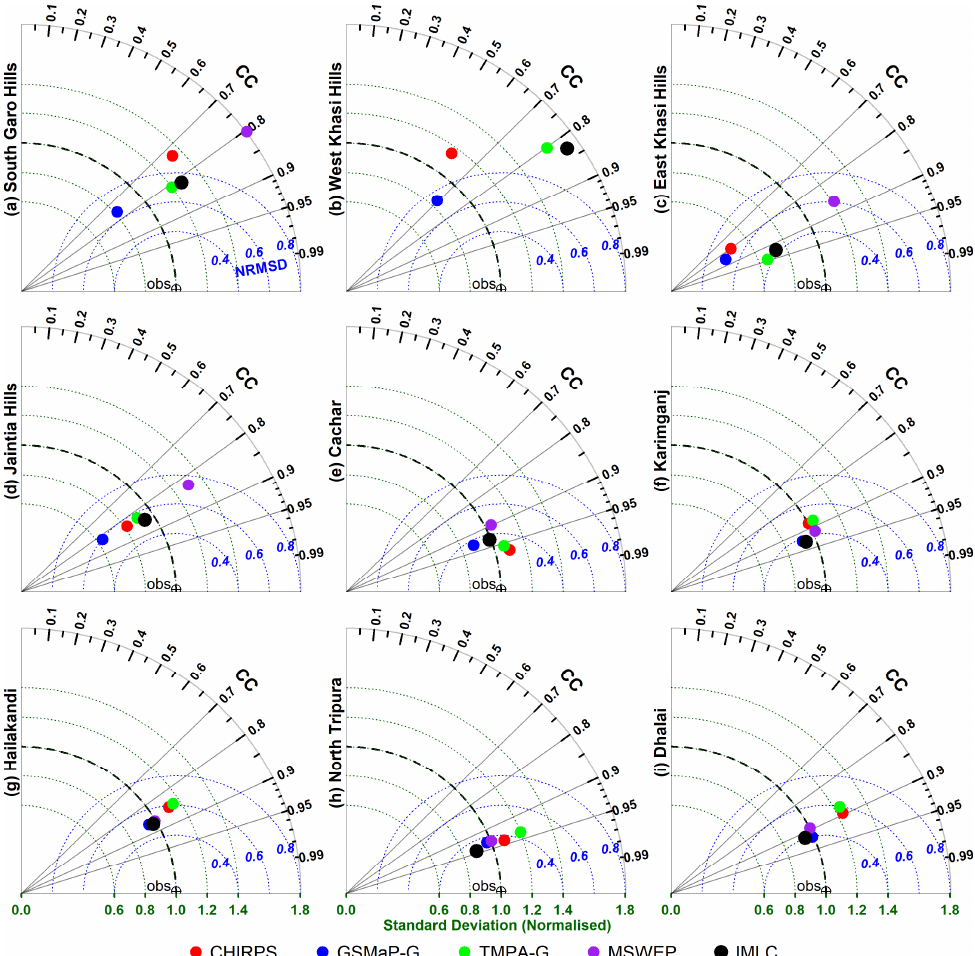
Figure 13. Taylor diagram with a comparison of the monthly accumulated district-average rainfall estimates (calculated from the original GSRPs) and IMLC product (the improved dataset created in this study) relative to the observed rainfall of nine districts ( a – i ) located inside the Indian portion of the Meghna basin for the period of 2012–2016. Instructions for reading a Taylor diagram are given in Figure 8.